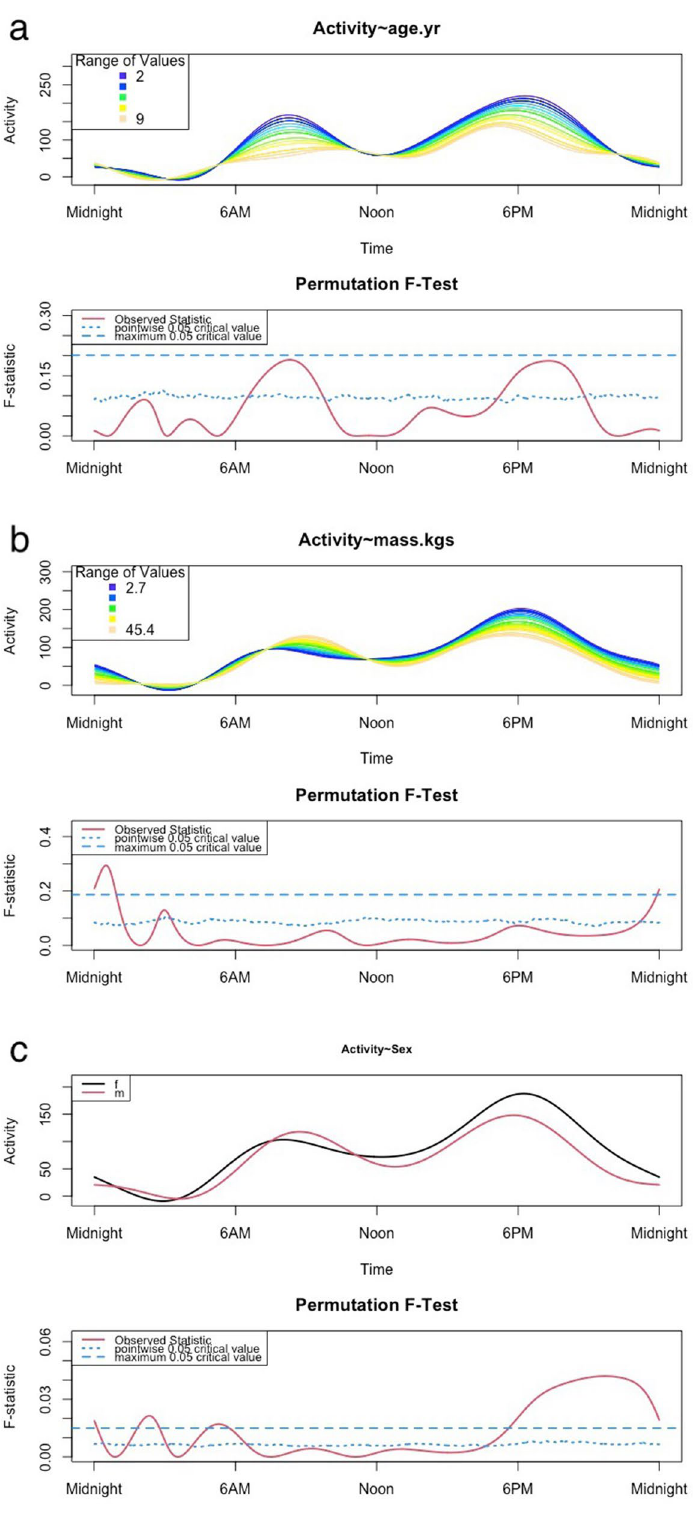
Figure 2. Functional linear models for the 24-h activity pattern showing comparison for ( a ) age, ( b ) mass, and ( c ) sex. Age and mass are continuous variables and sex is categorical. In the lower panel, the dotted blue line represents the point-wise critical value (proportion of all permutation F values at a significance level of 0.05) and the solid red line represents the observed F -statistic. When the solid line is above the dotted line, it means the groups differ significantly at those time